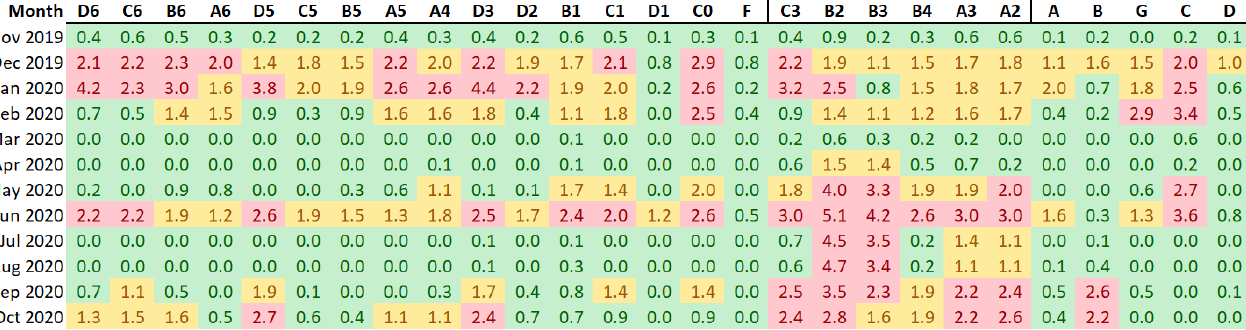
Figure 13. Percentage of out-of-band observations, for each month and each data-logger, with respect to the total. The number of out-of-band observations was computed by considering as a reference the median band width among data-loggers derived from EN 15757:2010. Values ≥ 2 are highlighted in red, <1 in green and the rest in orange.